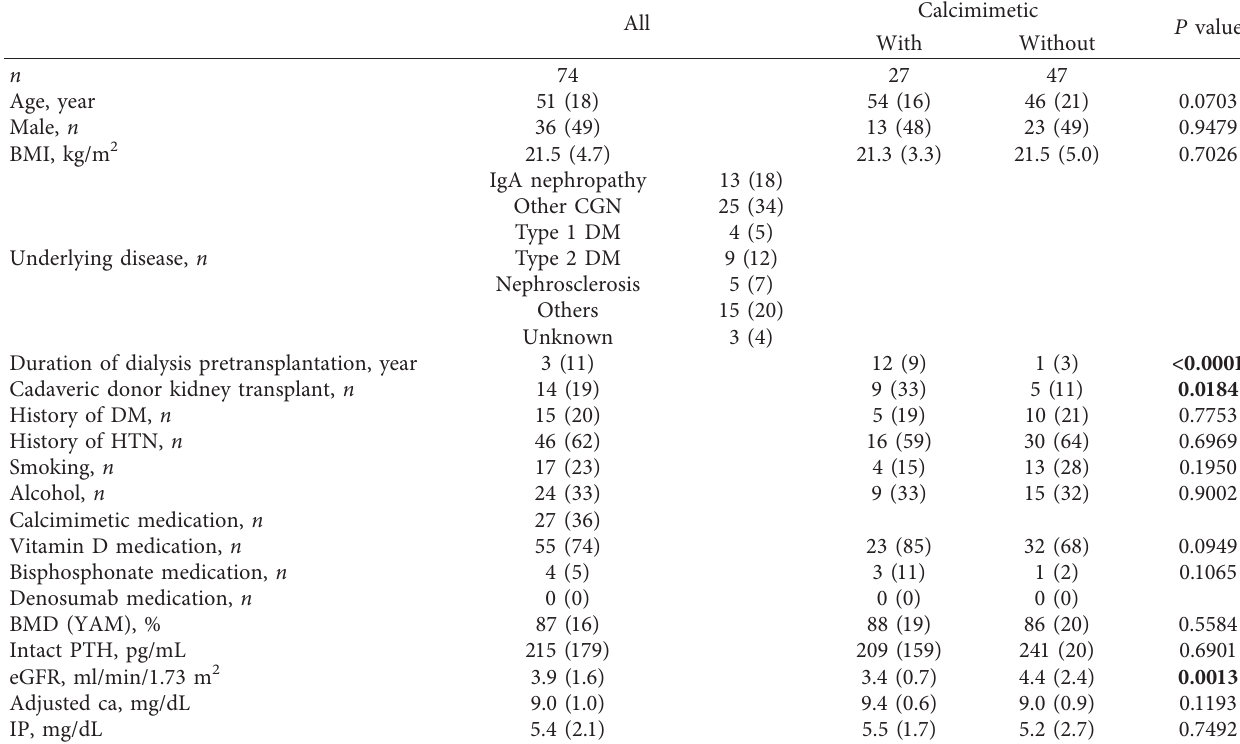
Table 1: Patient characteristics before